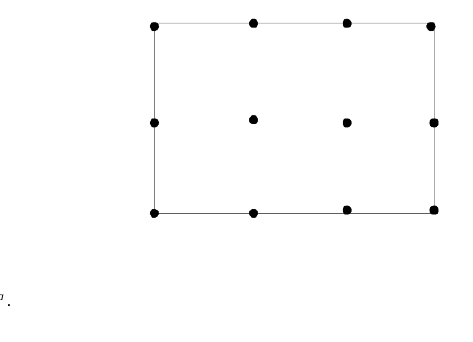
Figure 1. The Newton polytope of V a .